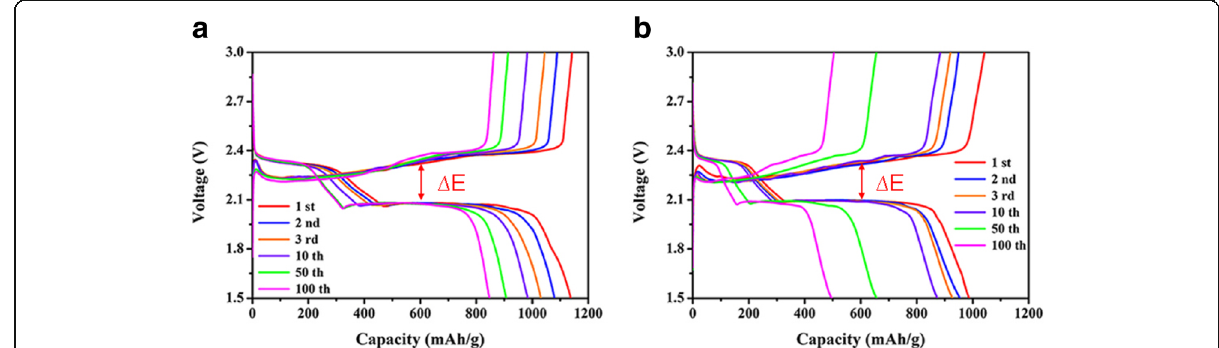
Fig. 4 Corresponding charge/discharge voltage-capacity profiles of cells assembled with CeO 2 /RGO composite coated separator ( a ) and pristine separator ( b